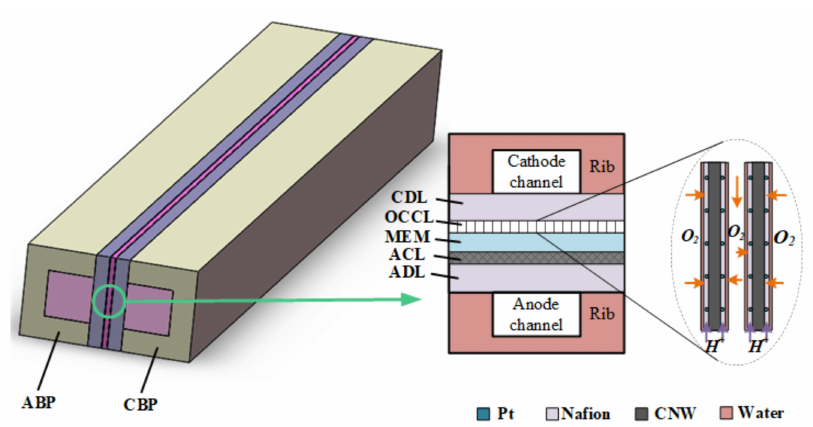
Figure 1. Flowchart of optimum triple-phase ratio of PEMFC.